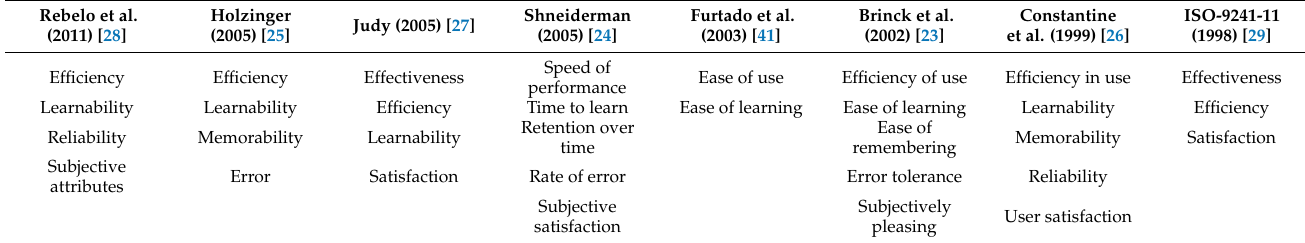
Table 1. Usability factors proposed by